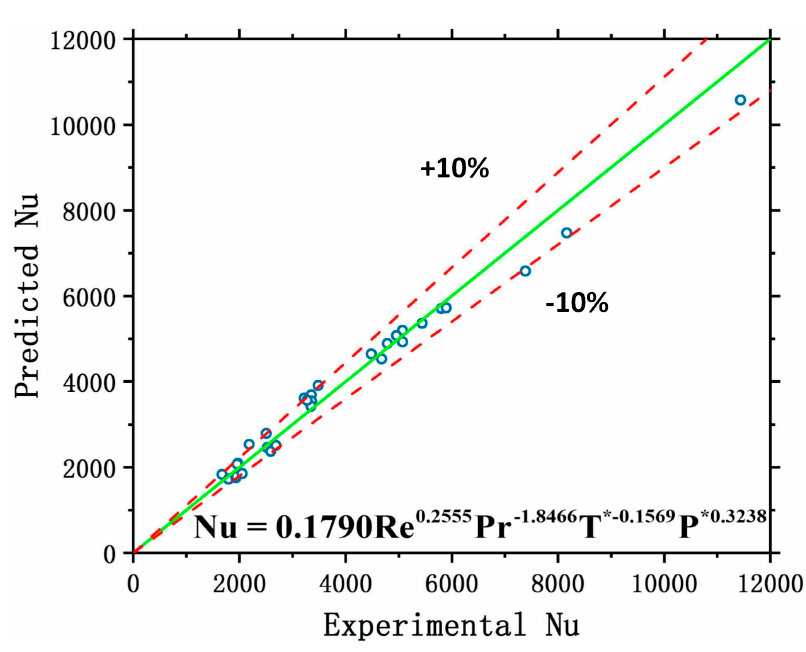
Figure 10. Comparison between experimental Nu and the predicted ones.